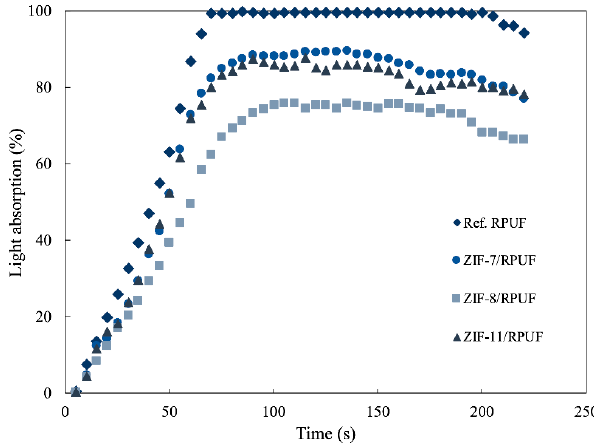
/ RPUF, ZIF-8 / RPUF and ZIF-11 /